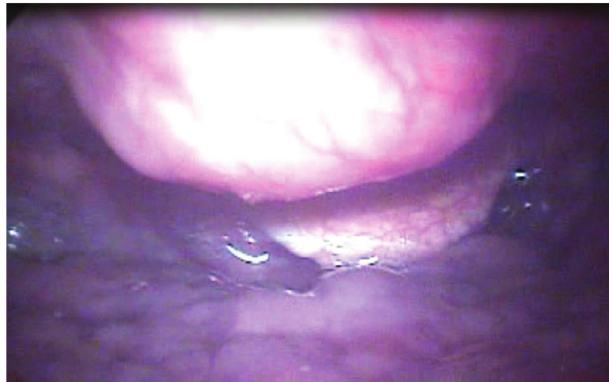
Figure 1 Video laryngoscopy image of a patient with Forestier’s disease, showing submucosal bulging in hypopharynx, corre- sponding to prominent cervical